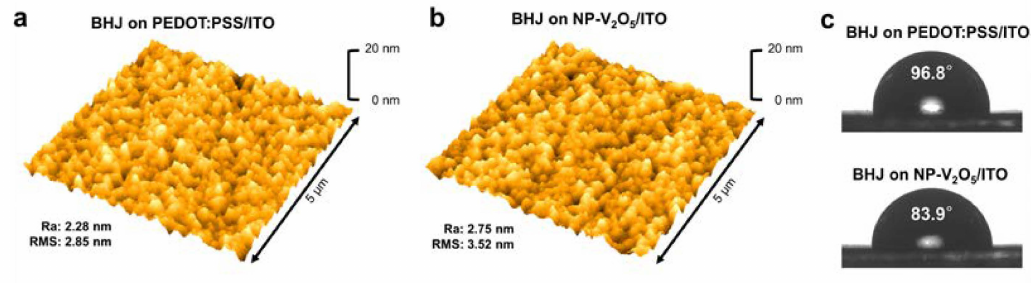
Figure 4. Atomic force microscopy (AFM) images of the bulk-heterojunction (BHJ) layer coated on the surface of ( a ) PEDOT:PSS and ( b ) NP-V 2 O 5 films; ( c ) Contact angle images of water droplets (12 µ L) on the surfaces of the BHJ / PEDOT:PSS and BHJ / NP-V 2 O 5